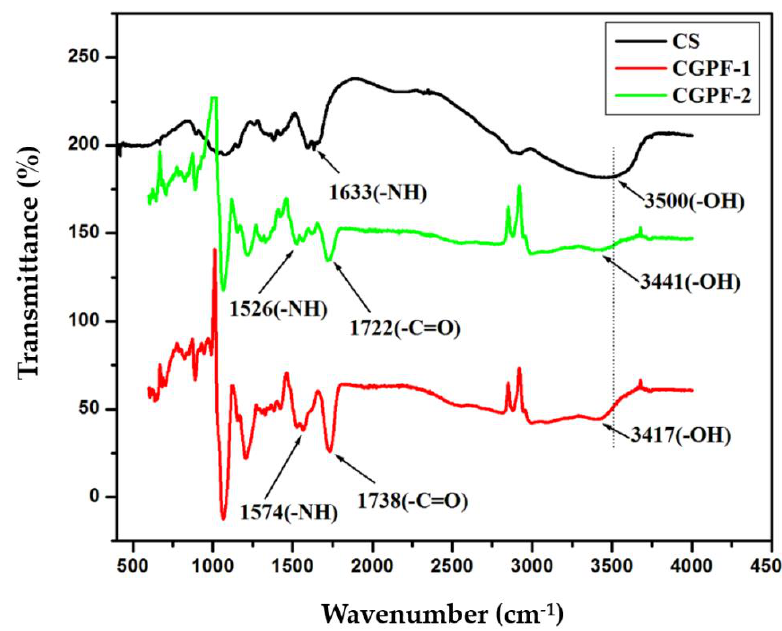
Figure 3. Chitosan (CS), glycolic acid-grafted–chitosan (CGPF − 1) and glycolic acid-grafted–chitosan– Pt–Fe 3 O 4 hybrid nanoparticles nanocomposite films FTIR spectra.